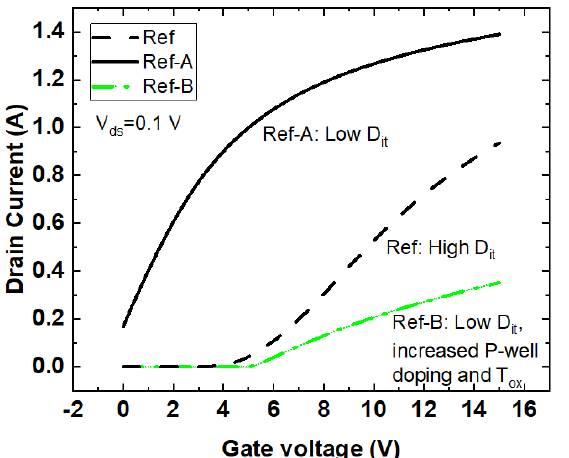
Figure 12. Transfer characteristics of the device with high Dit (Ref), low Dit (Ref-A) and proposed design modification (Ref-B).